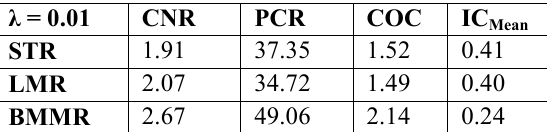
Fig.5: Conductivity reconstruction of the phantom with inhomogeneity (D = 30 mm, L = 37.5 mm) near electrode No.-3 (λ = 0.01): (a) original object, (b) image with STR, (c) image with LMR, (d) image with BMMR. Table-1: CNR, PCR and COC of the conductivity images of Fig. -5 λ =